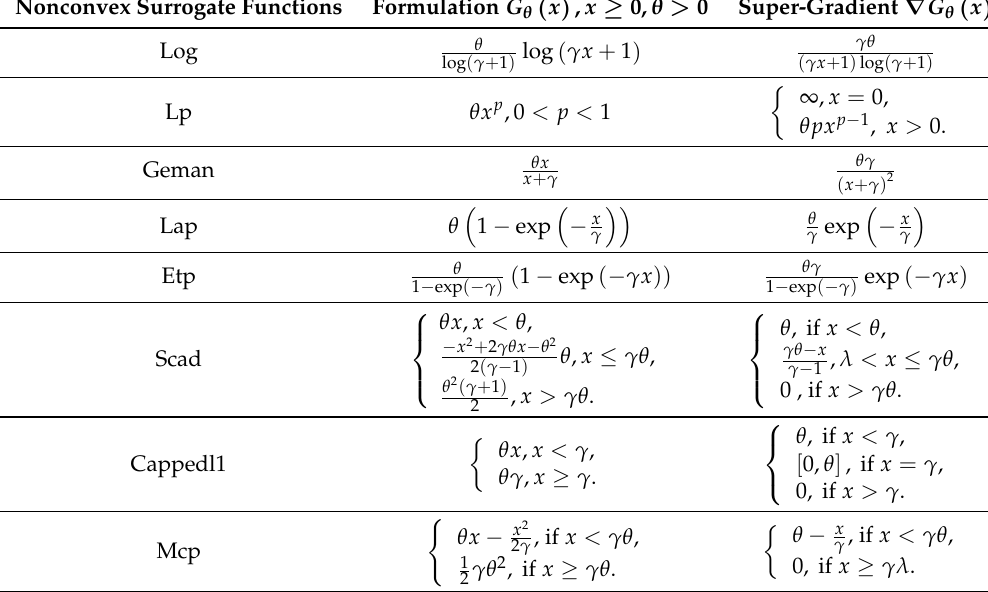
Table 1. Generalized nonconvex surrogate functions.